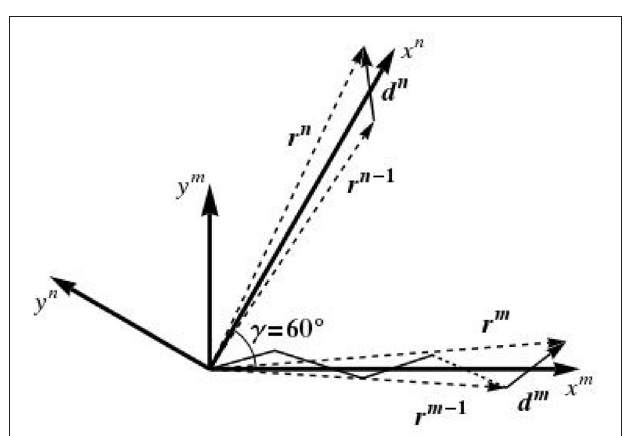
FIGURE 5 | 1D paracrystal in initial and rotated positions.